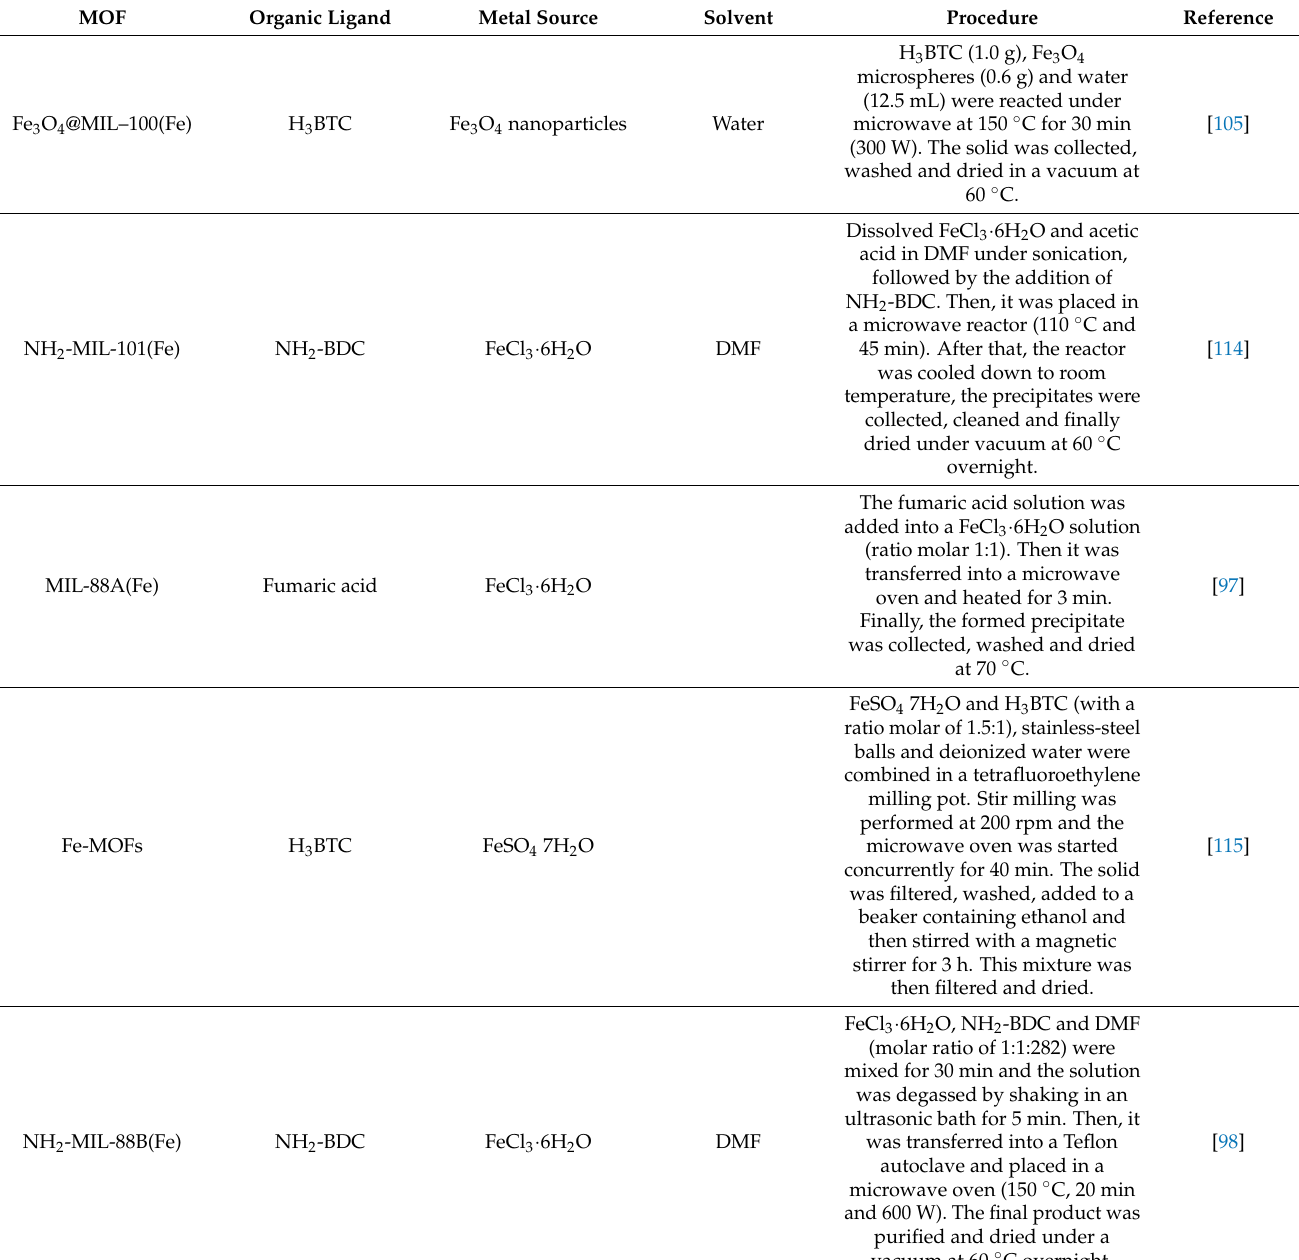
Table 5. Examples of Fe-MOF that were synthesized by the microwave-assisted